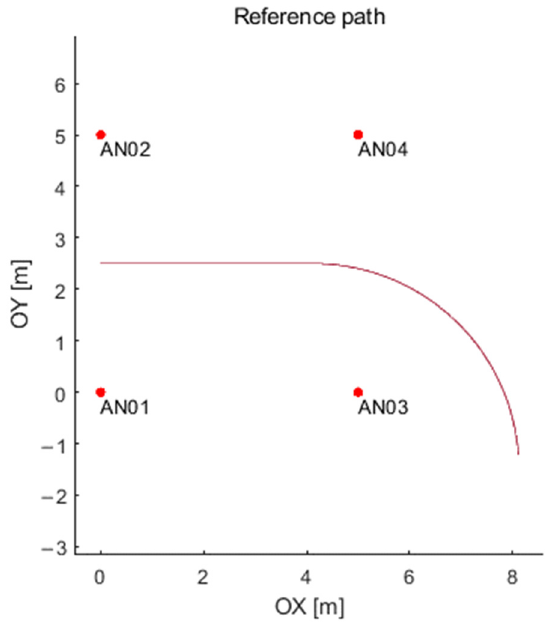
Figure 17. An sample reference path build of line and arc.